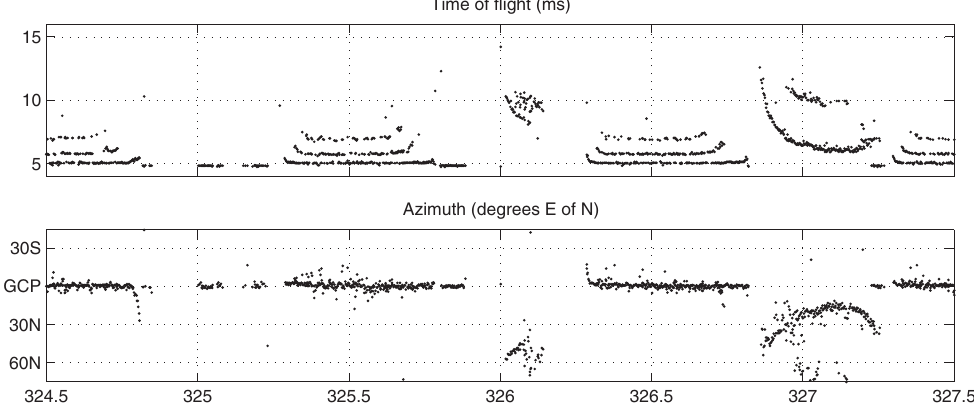
Fig. 14.2. Measurements made at 10.4 MHz between noon on 20th November 2001 (day 324) and noon on 23rd November 2001 (day 327). The upper panel represents the time of flight (ms), and the lower panel the az- imuth of the strongest mode